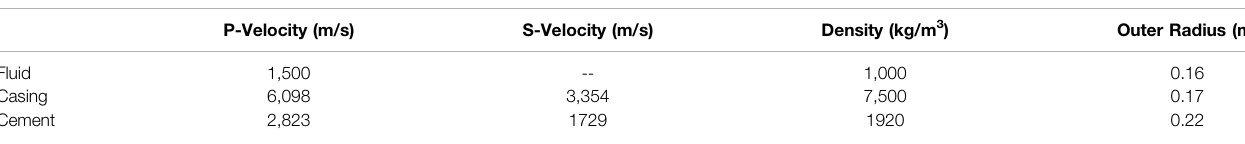
TABLE 2 | Model parameters of the nearby cased